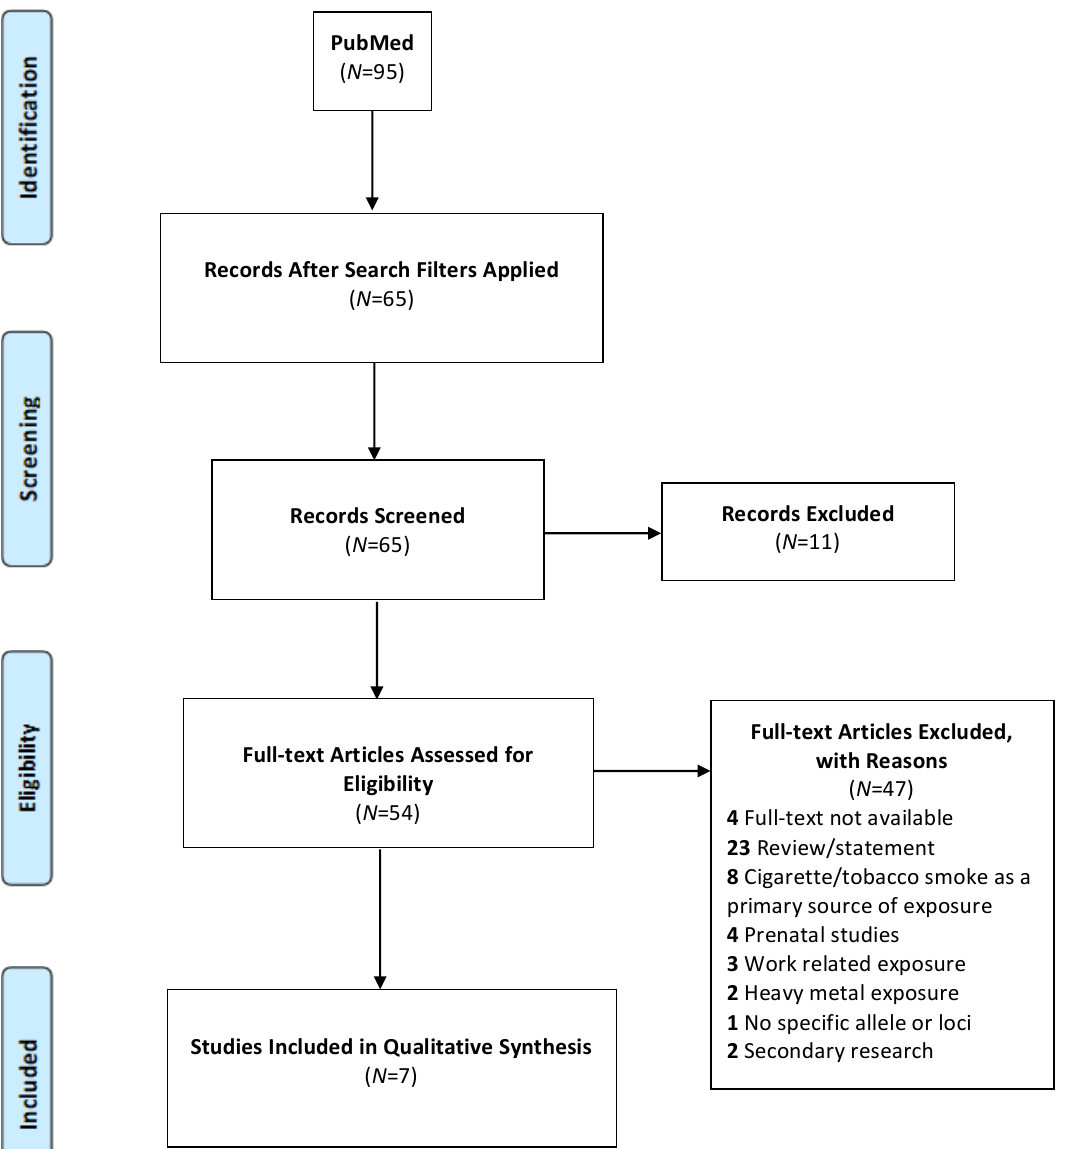
Figure 1. Study Design and Article Extraction.